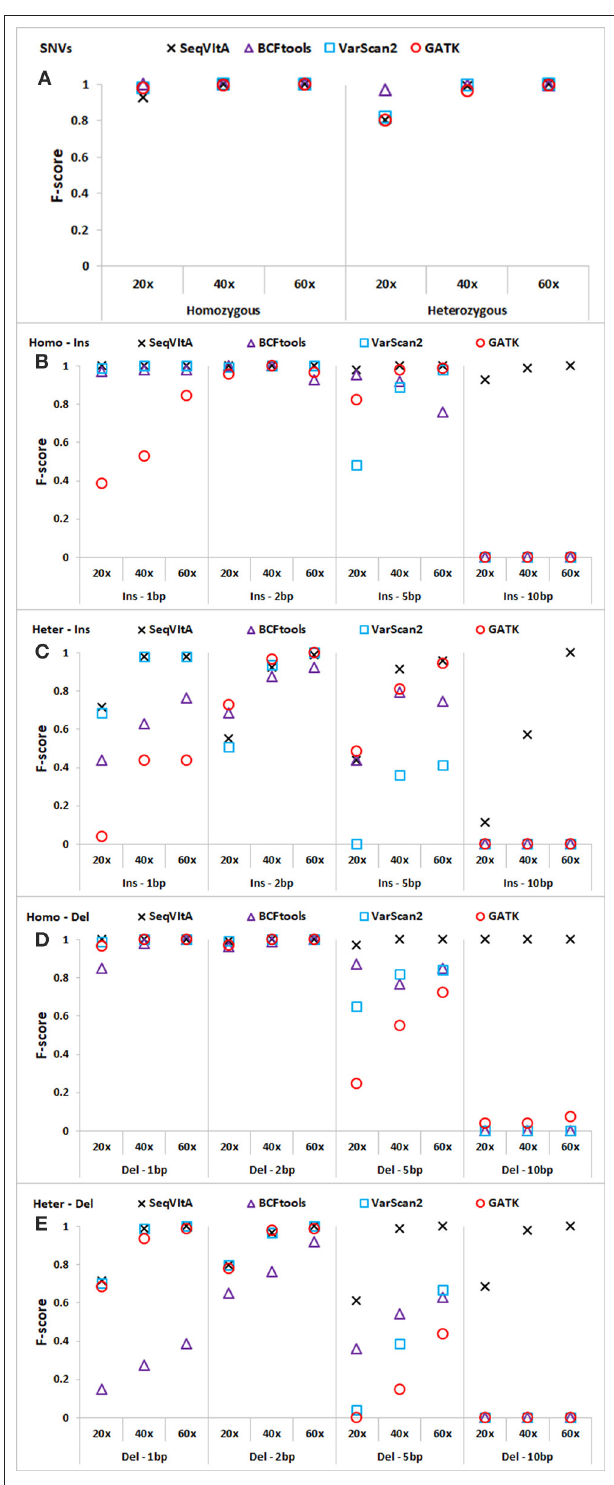
FIGURE 4 | Performance comparison of SeqVItA with BCFtools, VarScan2 and GATK on simulated data at three sequencing depths 20 × , 40 × , and 60 × in detecting homozygous (Homo) and heterozygous (Het) (A) SNVs, (B,C) insertions (Ins), and (D–E) deletions (Del). Read length = 100 bp, and base quality threshold ≥